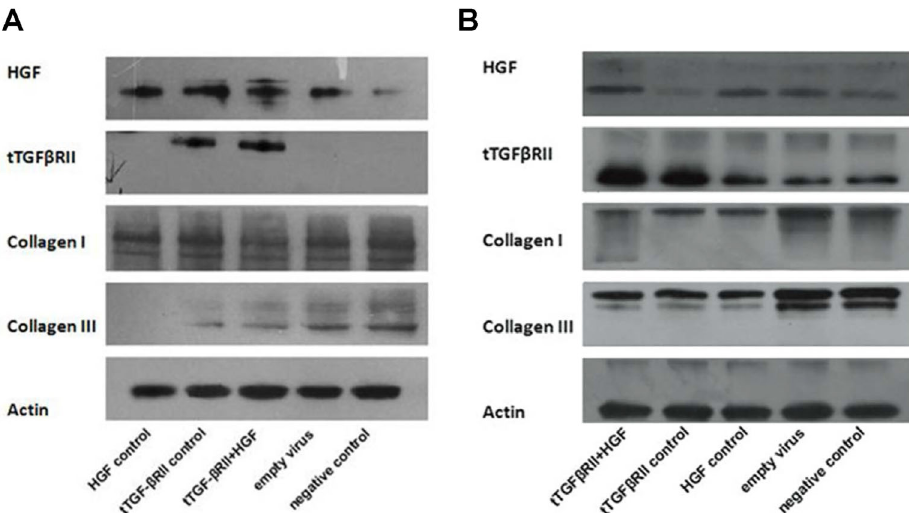
Figure 1. Expression of t-TGF- b RII, HGF, and collagen I and III in vitro and in vivo . A , In the in vitro experiment, the expression of collagen III was reduced in HGF control, t-TGF- b RII, and experimental groups compared with that in the blank and negative control groups. The result was most prominent in the HGF control group. B , In the in vivo experiment, the expression of collagen I and III was signi fi cantly reduced in the HGF control, t-TGF- b RII, and experimental groups after 14 days of treatment. t-TGF- b RII: truncated transforming growth factor- b type II receptor; HGF: hepatocyte growth